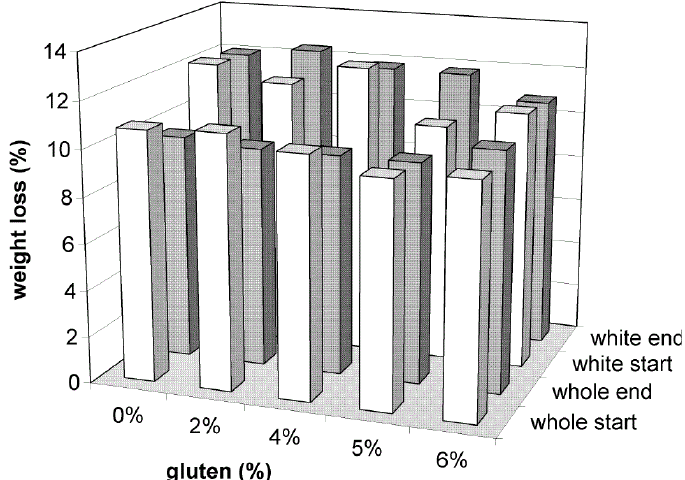
Figure 2. Specific volume (mL/g) of bread samples made from white (start = 11 days, end = 111 days) and whole wheat flour (start = 10 days, end = 110 days).